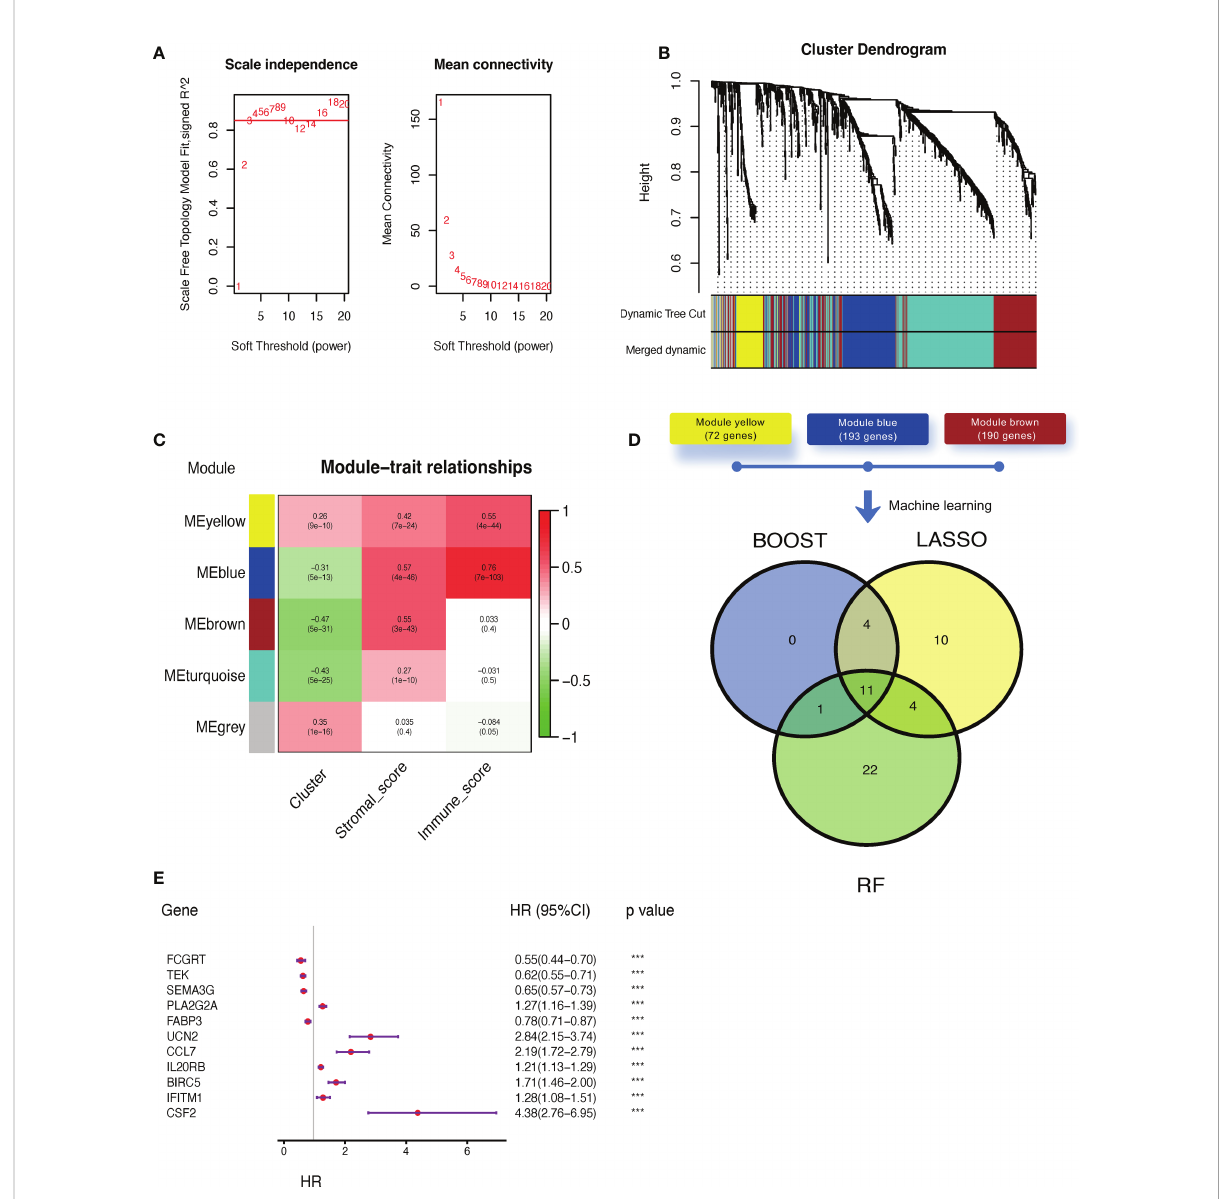
FIGURE 4 Construction of a claudin-TME related (CTR) risk signature. (A) Analysis of the scale-free fi t index (left) and mean connectivity (right) for different soft-thresholding (power) values (numbers colored with red). (B) Gene clustered dendrogram based on dissimilarity measure (1-topological overlap matrix (TOM)) with de fi ned module colors. (C) Heatmap of the correlations between module genes and cluster, stromal, or immune scores. (D) Venn plot showing the overlapping genes selected by three machine learning algorithms: CoxBoost, least absolute shrinkage